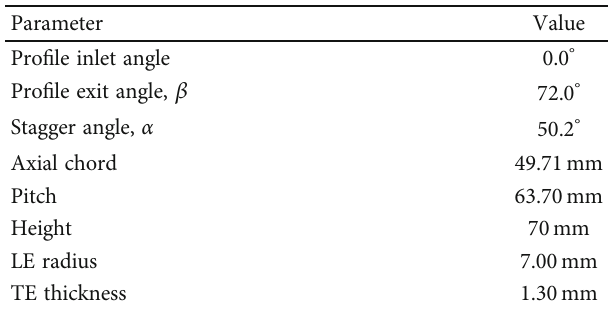
Table 1: Pro fi le geometry parameters.